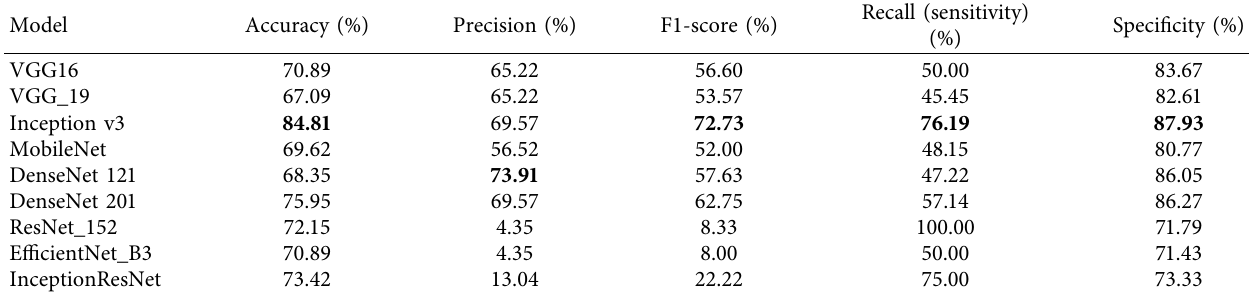
Table 2: Te results for all models in applying the feature extraction and classifcation task using deep learning architectures. Model